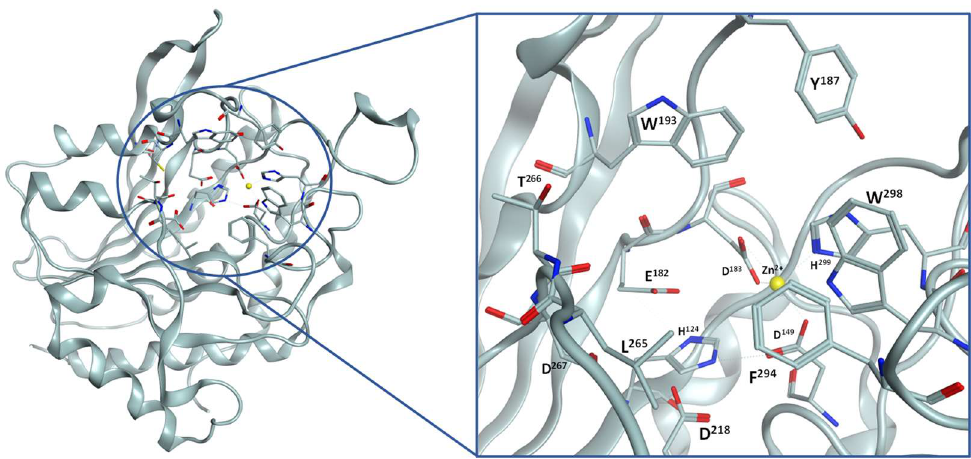
Figure 2. left: Overall structure of PgQC (pdb: 6QQL); right: detailed view of the active site.